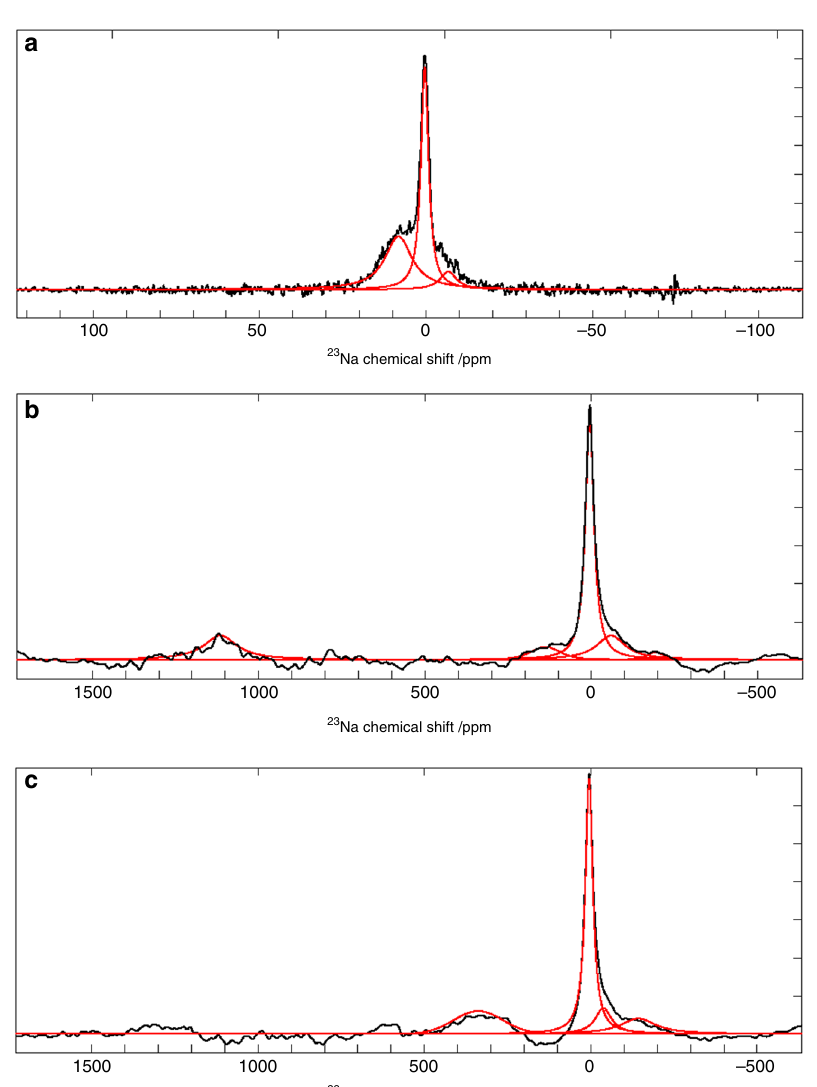
Fig. 6 Selected in operando 23 Na NMR spectra for a NIB full-cell during formation cycle. a 23 Na NMR spectrum from electrolytic region for pristine ( t = 0) cell. Full 23 Na NMR spectra 2.0 h ( b ) and 4 h ( c ) after charging, at a speci fi c current of 30 mA g − 1 , started. Experimental spectra are shown in black and the fi tted peaks are given in red. Deconvolution values for these spectra can be found in Supplementary Table